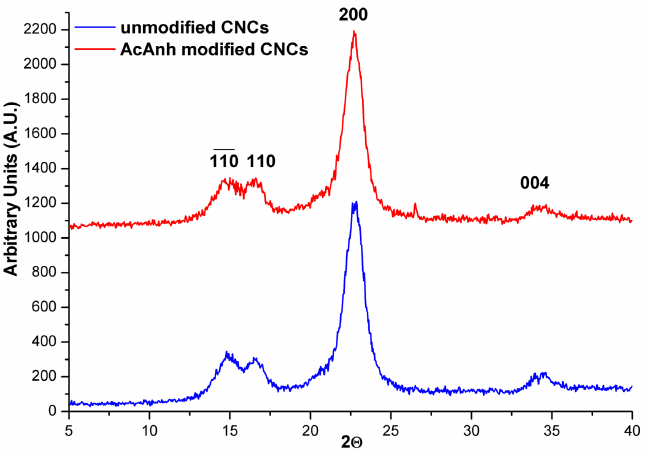
Figure 7. XRD diffractograms of neat CNCs (blue) and CNCs modified with AcAnh